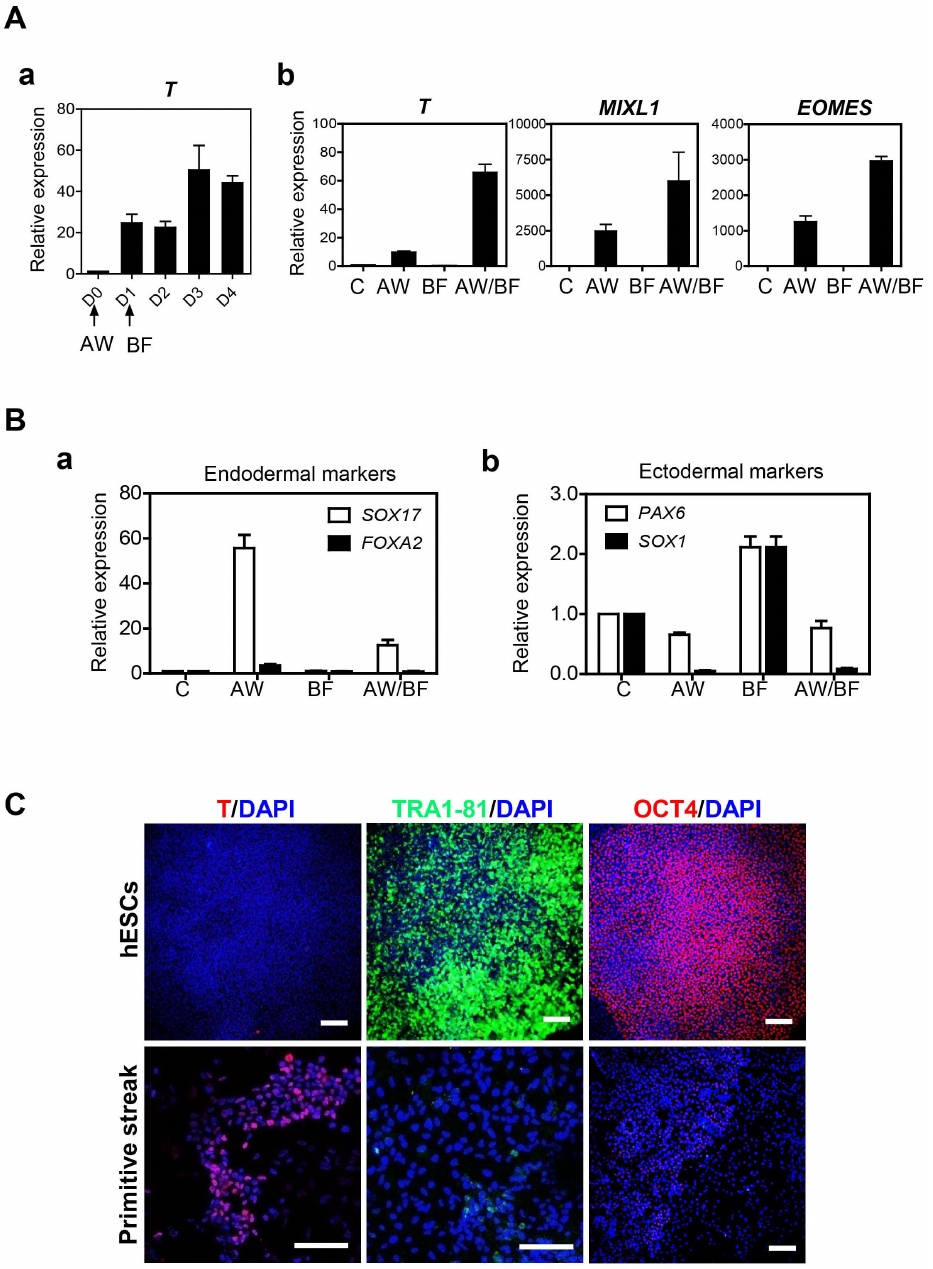
Figure 2. Induction of hESCs into primitive streak (PS) cells. A. (a) Optimal duration for PS induction was determined by transcription level of T compared with undifferentiated hESCs before treatments. Relative gene expression was normalized to GAPDH, and the values of fold-changes are represented by mean 6 S.E.M (n=3). (b) Comparison of expression levels of PS specific genes by combinatorial treatments with exogenous factors of Activin A, Wnt3a (AW) and BMP4, FGF2 (BF), in hESC-derived PS cells. Untreated samples were designated as (C). Relative transcriptional levels were normalized to GAPDH, and the bars show mean 6 S.E.M (n=3). B. (a) Determination of heterogeneity with other germ layers such as definitive endoderm (DE) and ectoderm by evaluating transcriptional expression of (a) DE and (b) ectoderm marker genes in hESC-derived PS cells. C. Immunofluorescence of T (red), TRA1-81 (green), and OCT4 (red) expression in the cells of induction day 0 (undifferentiated hESCs) and day 3 (primitive streak). Scale bars=200 m